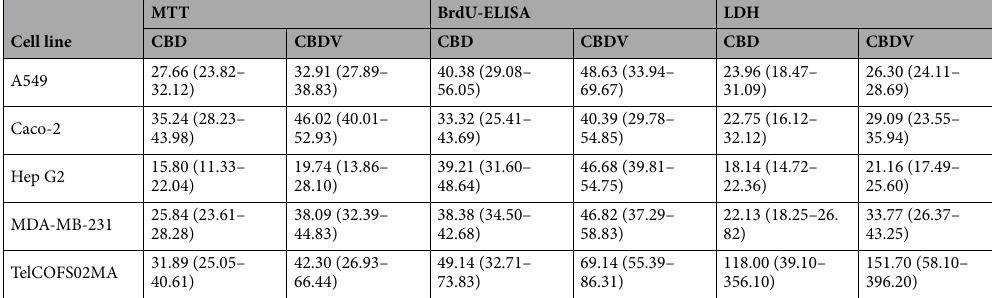
Table 1. IC50 values obtained by MTT assay, BrdU-ELISA and LDH assay. MTT assay, BrdU-ELISA and LDH assay IC50 values, expressed in µM, with confidence intervals of 95% for the cell lines after 72 h of exposure to CBD and CBDV.